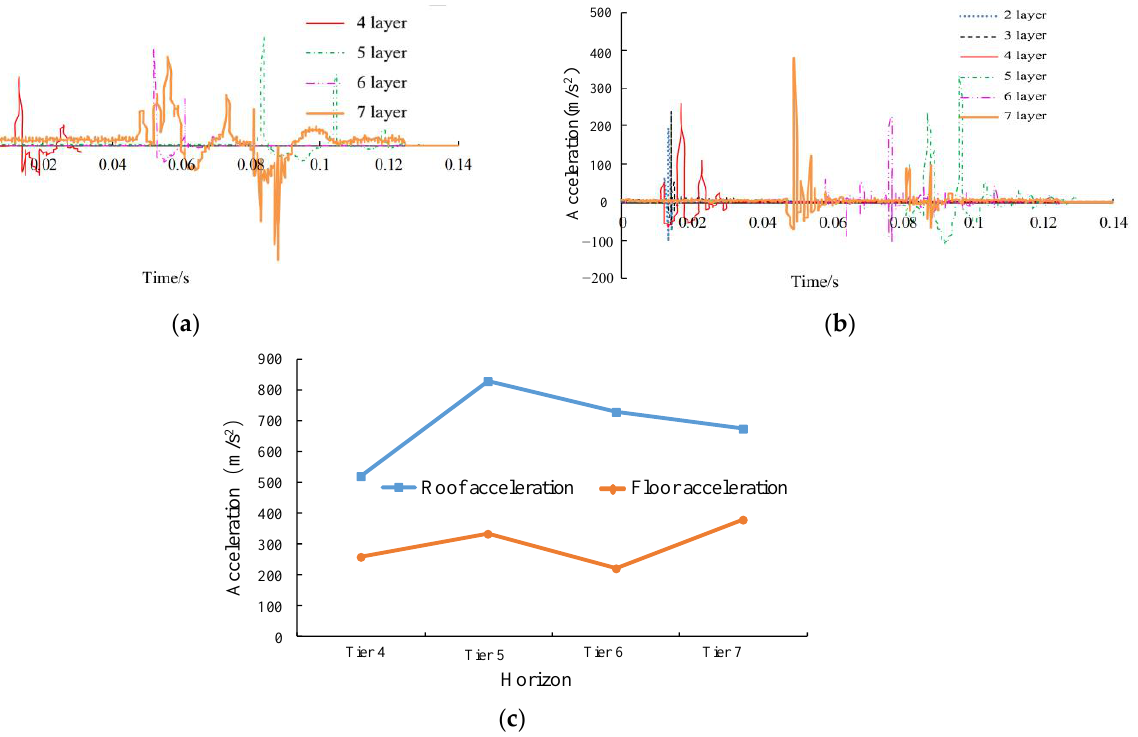
Figure 19. Acceleration response characteristics of each layer when the pendulum height is 0.5 m. ( a ) Acceleration at the roof of surrounding rock; ( b ) Acceleration at the floor of the roadway; ( c ) Peak acceleration at each level.